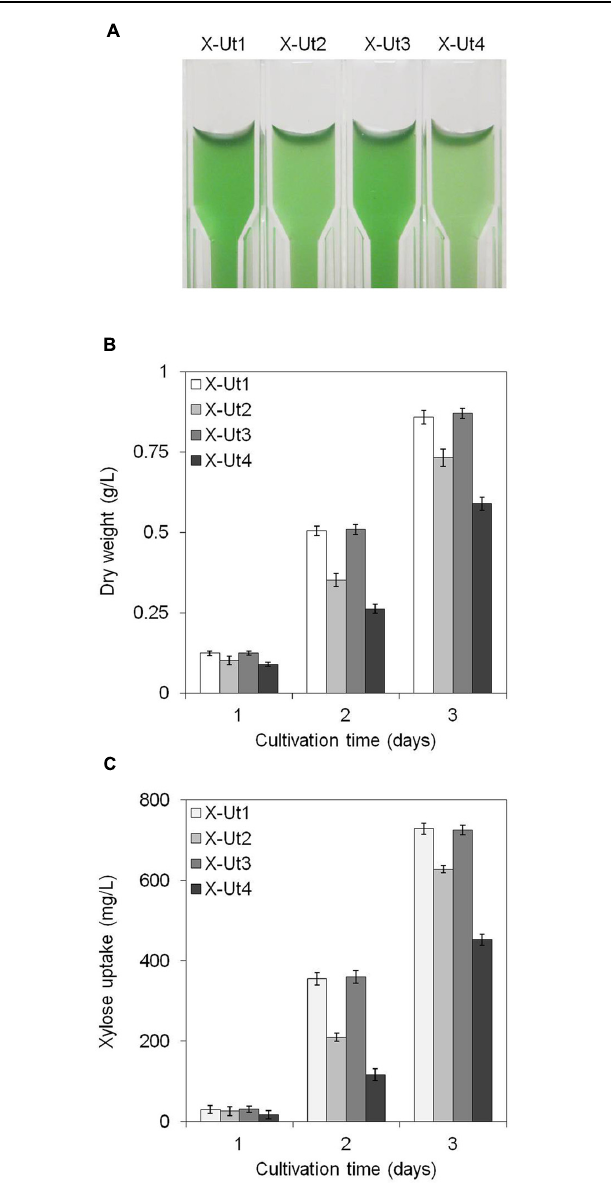
FIGURE 8 | Growth and xylose consumption under mixotrophy in the presence of 5 mM xylose. Synechocystis strains X-Ut1, X-Ut2, X-Ut3, and X-Ut4 were grown in the presence of 5 mM (750 mg/L) xylose. (A) Photograph depicting differential growth shown by the transformant strains at the end of second day of culture. (B) Dry biomass values estimated at the end of first, second, and third days. (C) Xylose consumption at the end of the first, second, and third day exhibited by the transformant strains, determined from the measurement of residual xylose in filtered cell-free medium. Data represented in graphs were collected from three biological replicates and presented as means ± standard